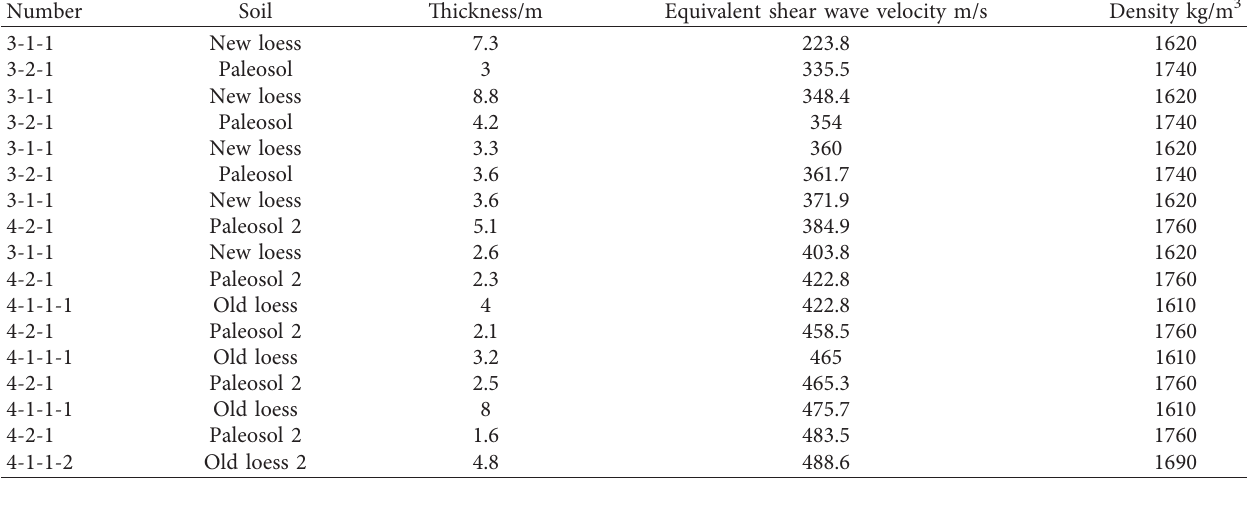
Table 2: Soil properties from shallow to deep.